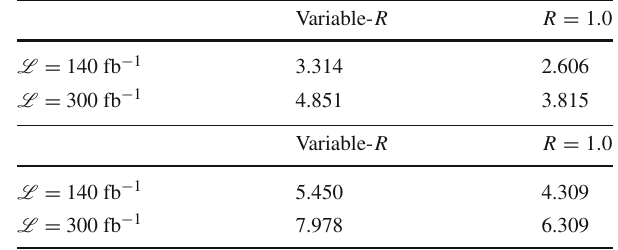
Table 6 Event rates of signal and backgrounds for L = 140 fb − 1 upon enforcing the initial cuts plus the mass selection criteria of Fig. 8 for the two jet reconstruction procedures Process